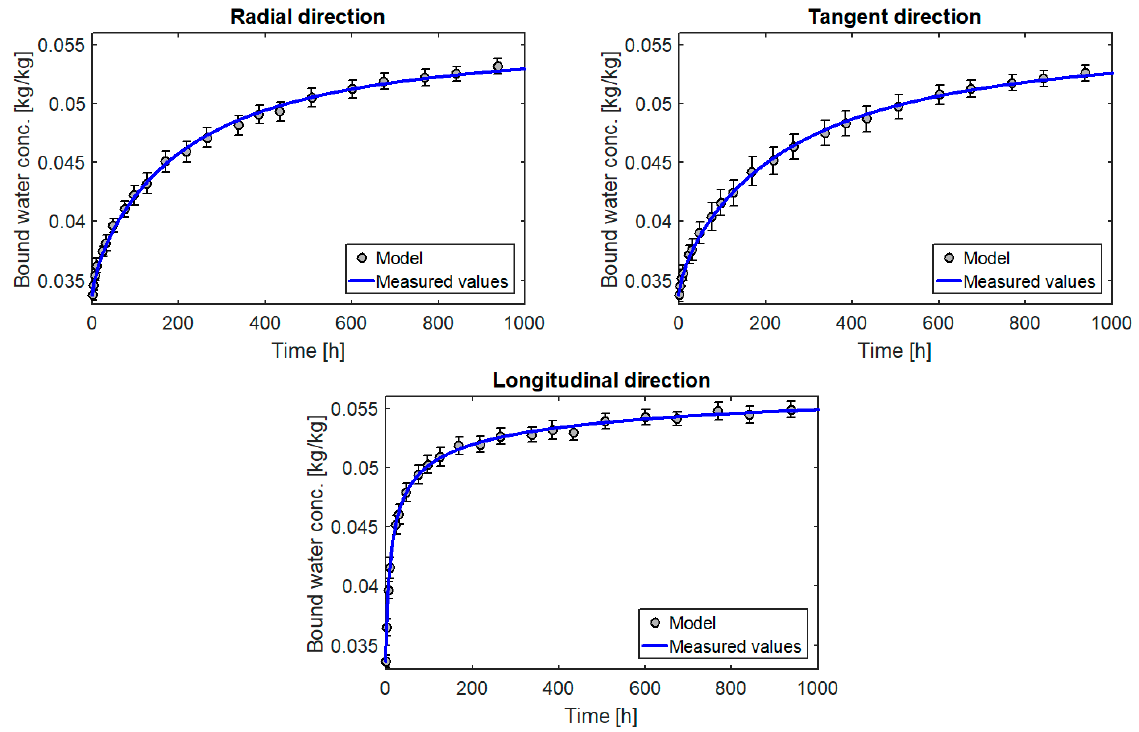
Figure 10. Changes in the moisture content of the oak samples versus time.